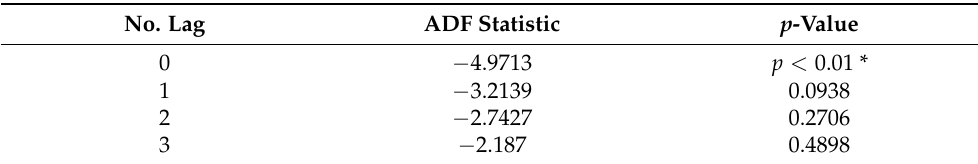
Table 2. Augmented Dickey–Fuller test for stationary of the yield .